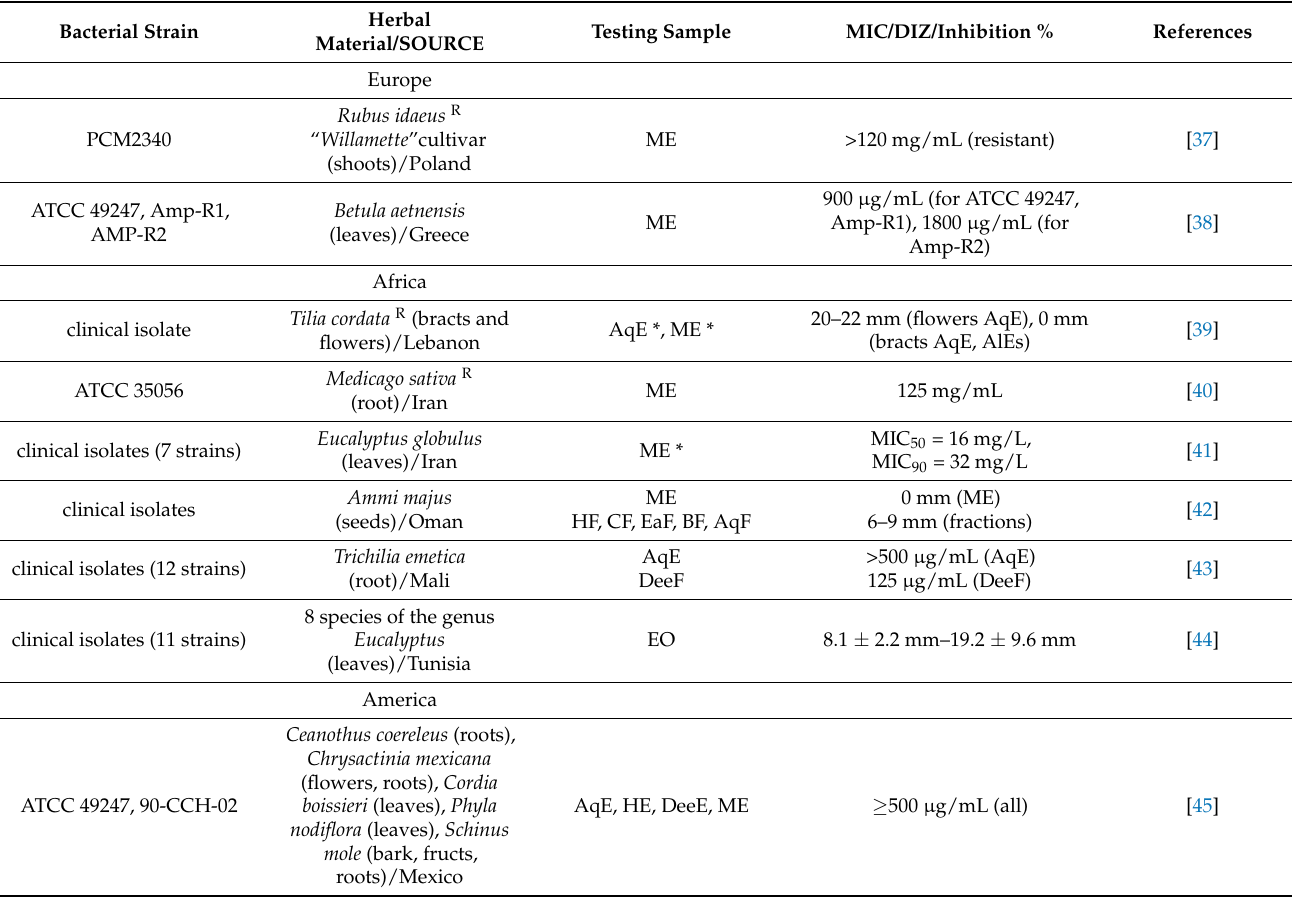
Table 3. Medicinal plants tested for the antimicrobial effect against Haemophilus influenzae